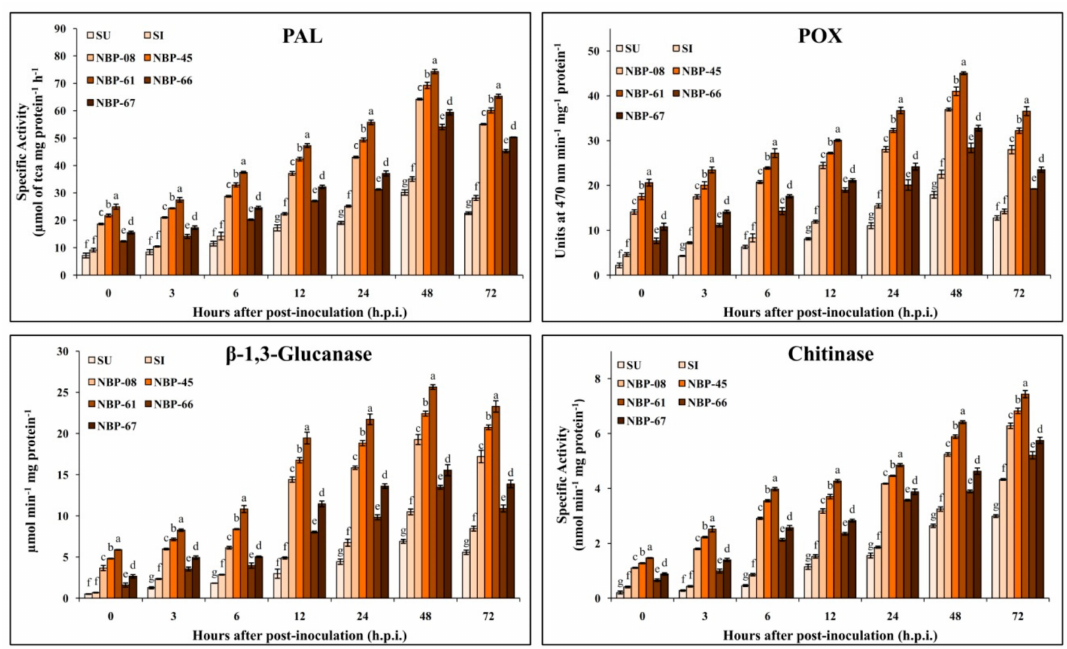
Figure 2. E ff ect of PGPF seed treatment on defense-related enzyme activity upon challenge inoculation with C. capsici in